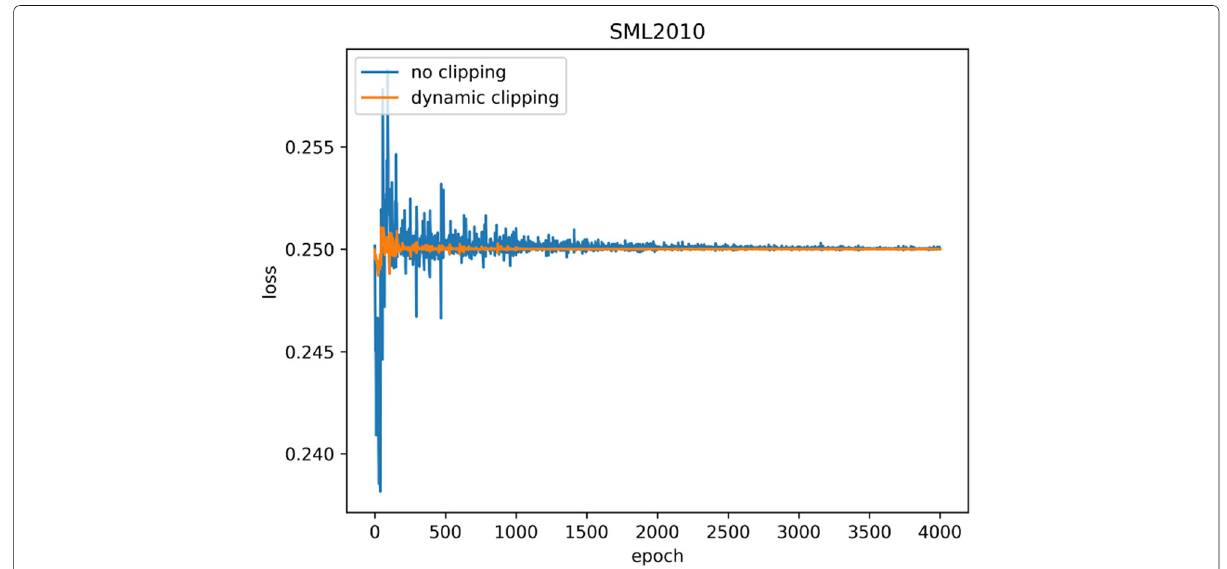
Fig. 5 The loss of the discriminator network